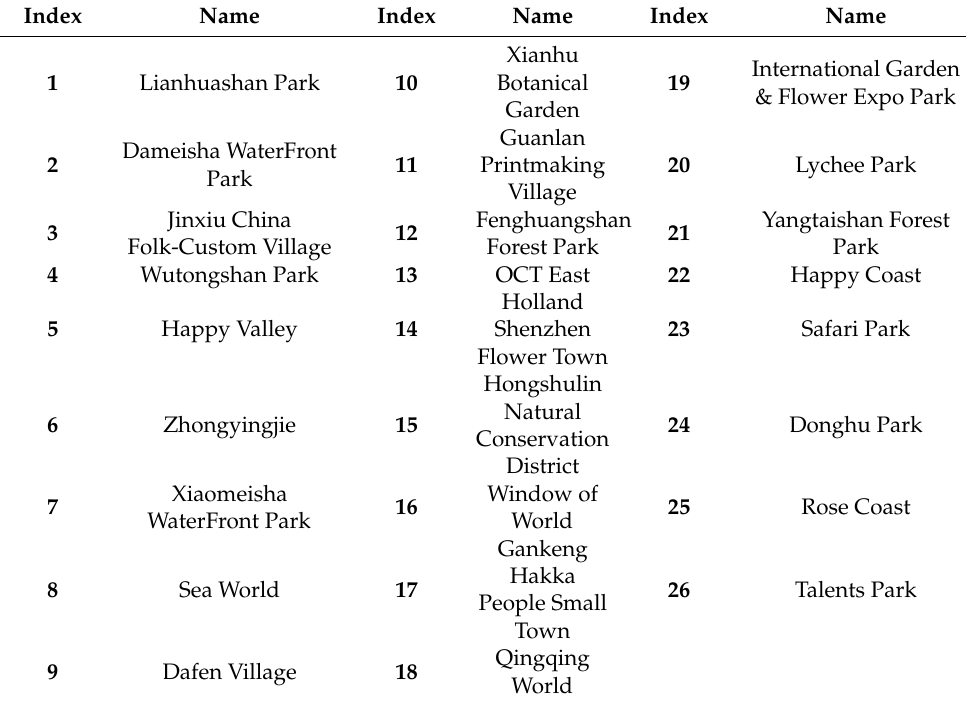
Table 1. List of tourist attractions in